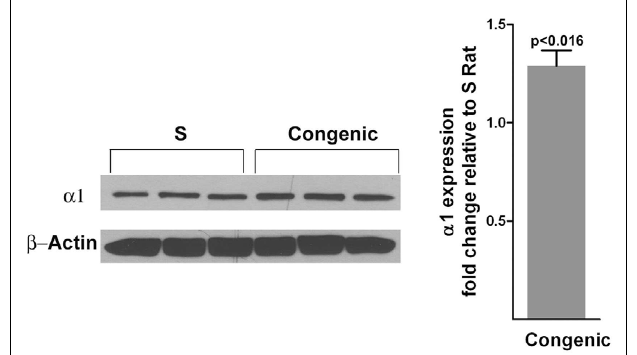
FIGURE 4 | Quantitation of the α -1 subunit of Na + K + ATPase on the plasma membranes of cells from proximal tubules ( n = 3 animals per group). The surface biotinylation experiment on isolated proximal tubules was conducted as described under methods.The top panel of the western blot was probed with antibodies to the α -1 subunit of Na + K + ATPase.The bottom panel was probed with antibodies to β -actin. Densitometric scans are shown on the right hand side.